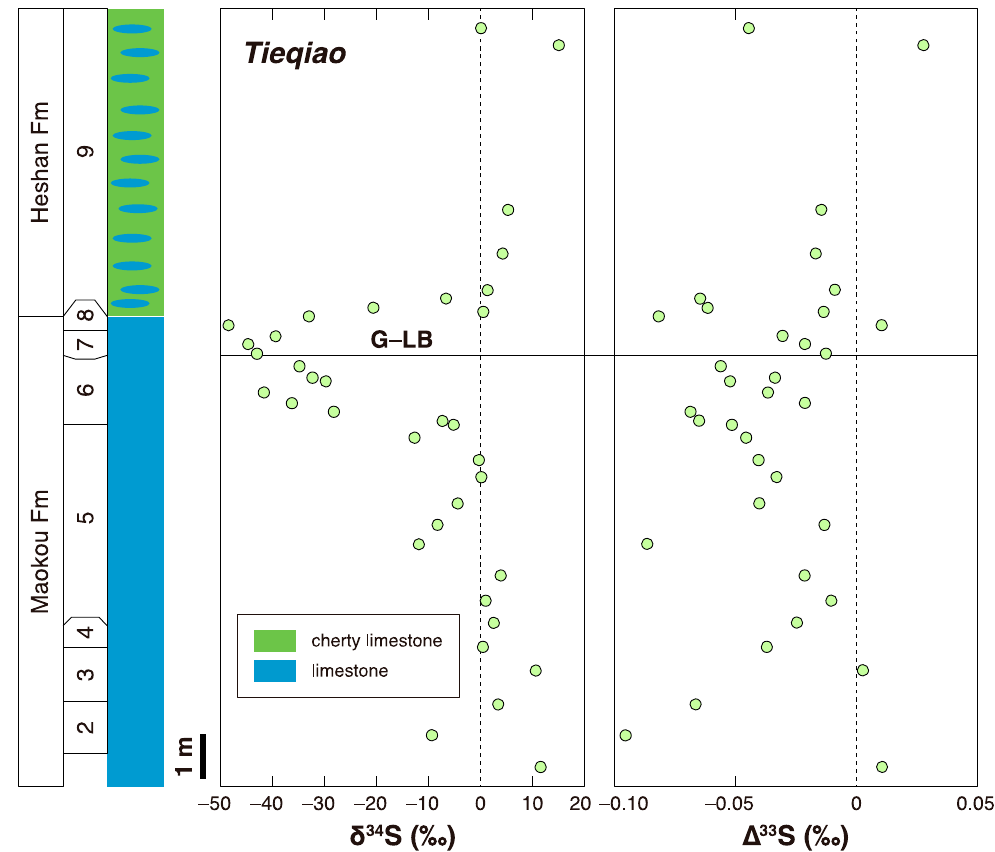
Figure 4. Multiple sulfur isotope chemostratigraphy across the G-LB at Tieqiao [69]. A number along the log is bed number. The timing and pattern of the extinction in the interval have not been well constrained.